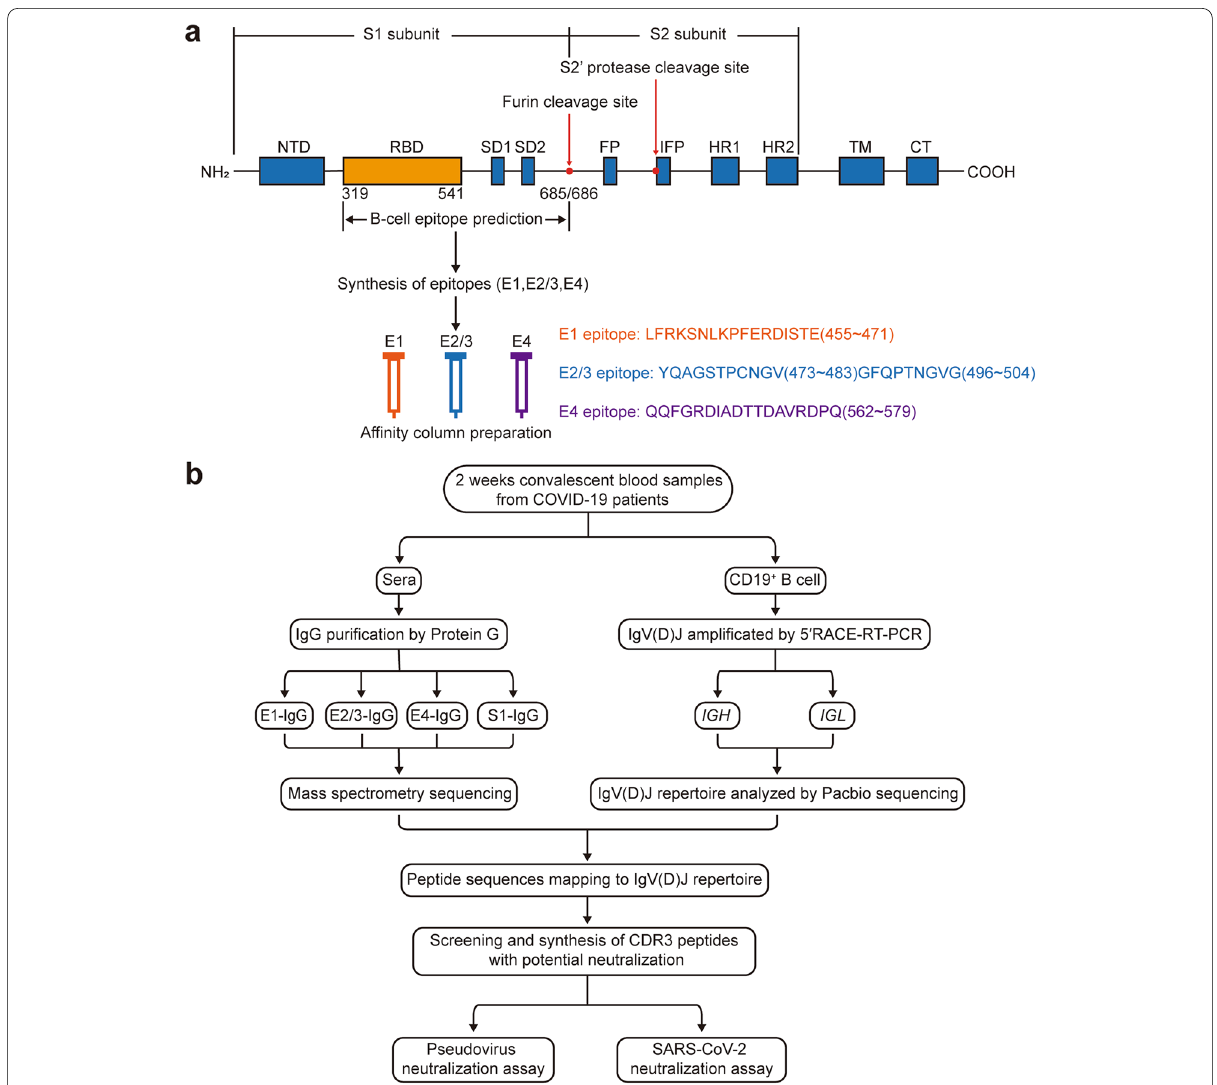
Fig. 1 Schematic diagram of obtain CDR3 of neutralizing antibodies against SARS-CoV-2. a The spike protein (S protein) of SARS-CoV-2 comprises two functional subunits: S1 subunit can bind to the host cell receptor ACE2 and S2 subunit mediated the fusion of the viral and host cell membranes. This S1/S2 boundary constitutes the cleavage site for the subtilisin-like host cell protease furin, which is ubiquitously expressed in humans. The distal region of S1 subunit comprises RBDs and stabilizes the prefusion state of the membrane-anchored S2 subunit which contains the fusion machinery. Four linear B cell epitopes are located on the receptor-binding domain (RBD) or adjacent RBD. Then, the epitope peptides were synthesized and coupled to CNBr-activated Sepharose 4FF to purify epitope peptide-specific IgG. NTD, N-terminal domain; RBD, receptor-binding domain; SD1, subdomain 1; SD2, subdomain 2; FP, fusion peptide; IFP, internal fusion peptide; HR1, heptad repeat 1; HR2, heptad repeat 2; TM, transmembrane domain; IC, intracellular tail. b This flowchart shows the detailed steps of the entire